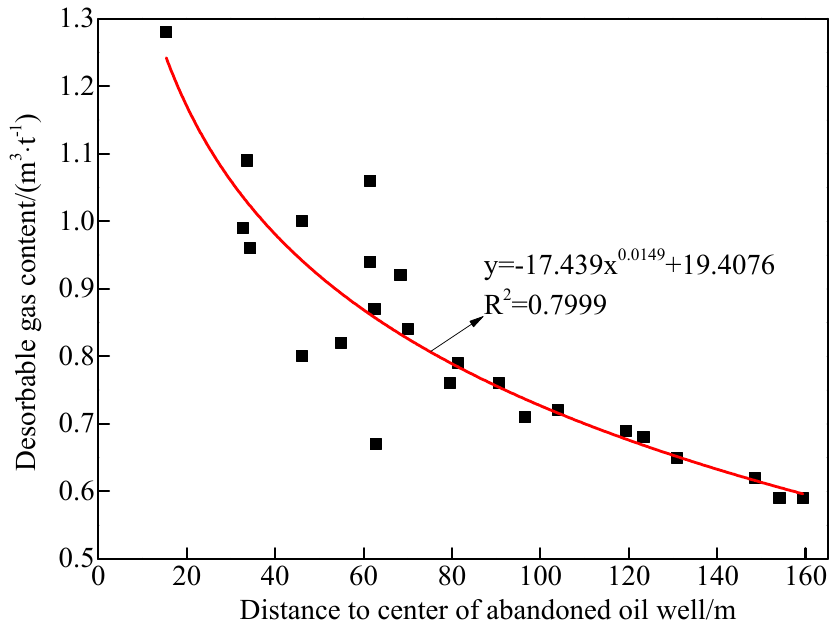
Figure 11. The distribution law of coal seam desorb gas content along the radial direction.